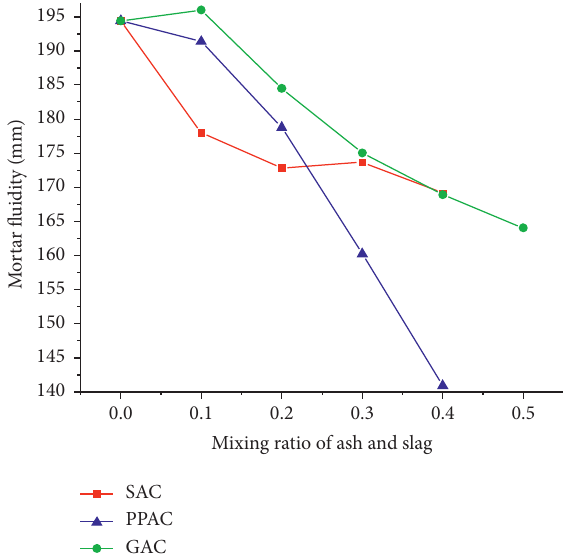
Figure 10: Effect of different dosage of waste residue on fluidity of colloidal